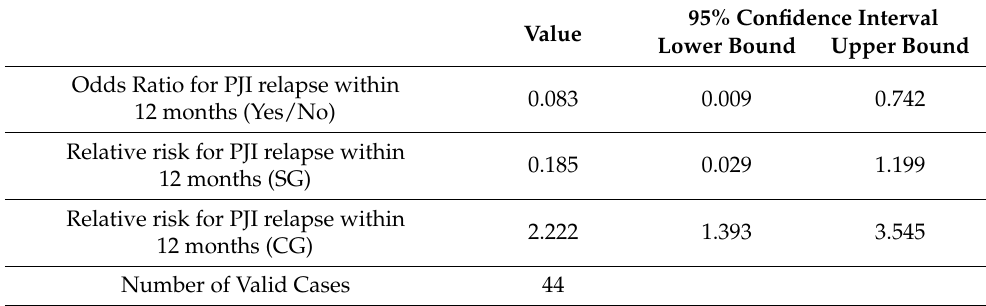
95% Confidence Interval Value Lower Bound Upper Bound 0.083